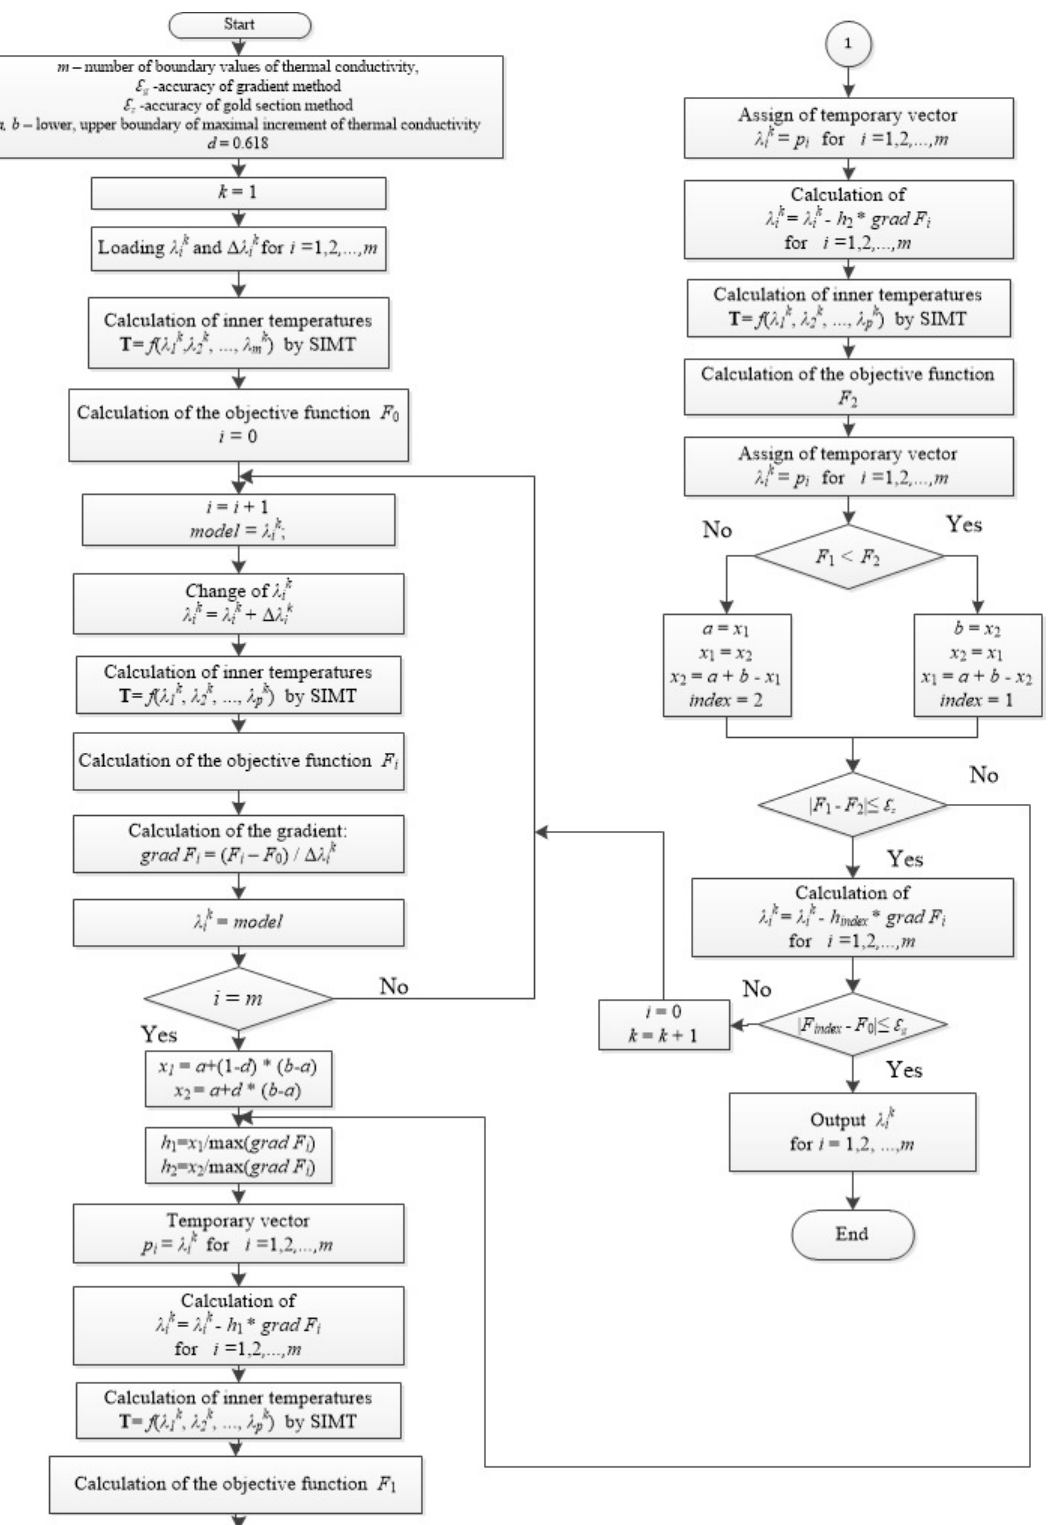
Figure 9. Modified gradient method algorithm for estimation of thermal